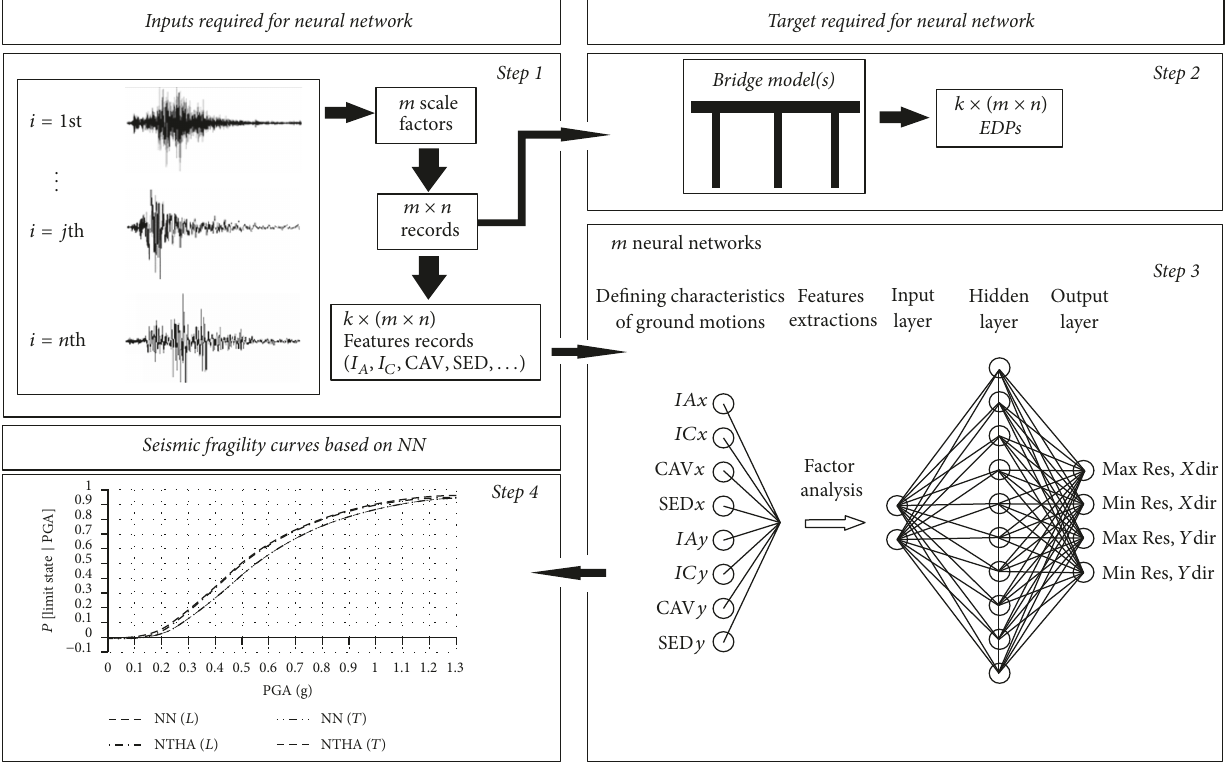
Figure 11: Fragility curves based on